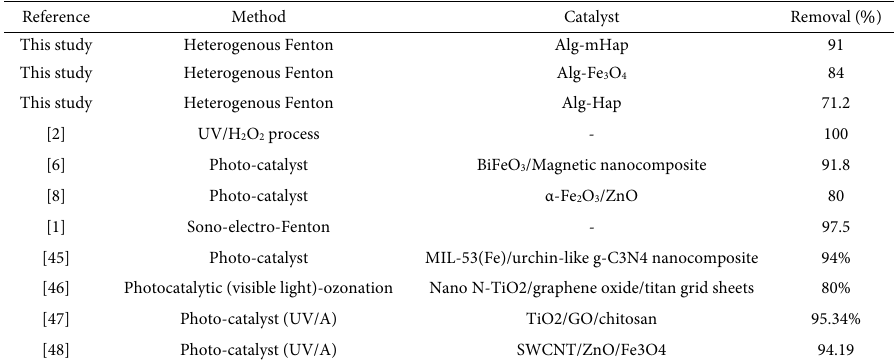
Table 4. Comparison of the cefixime removal percentage in different